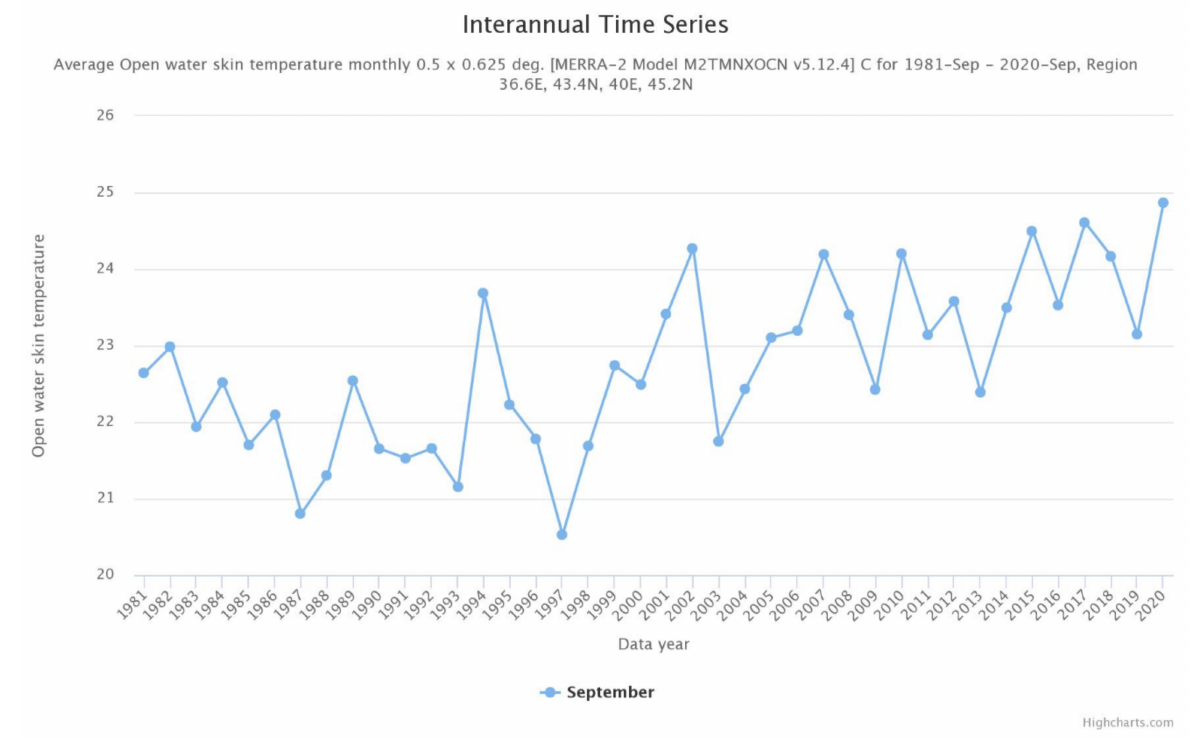
Figure 7. Interannual variability of the sea surface temperature in the northeastern Black Sea in September from 1981–2020 based on the MERRA-2 M2TMNXOCN V5.12.4